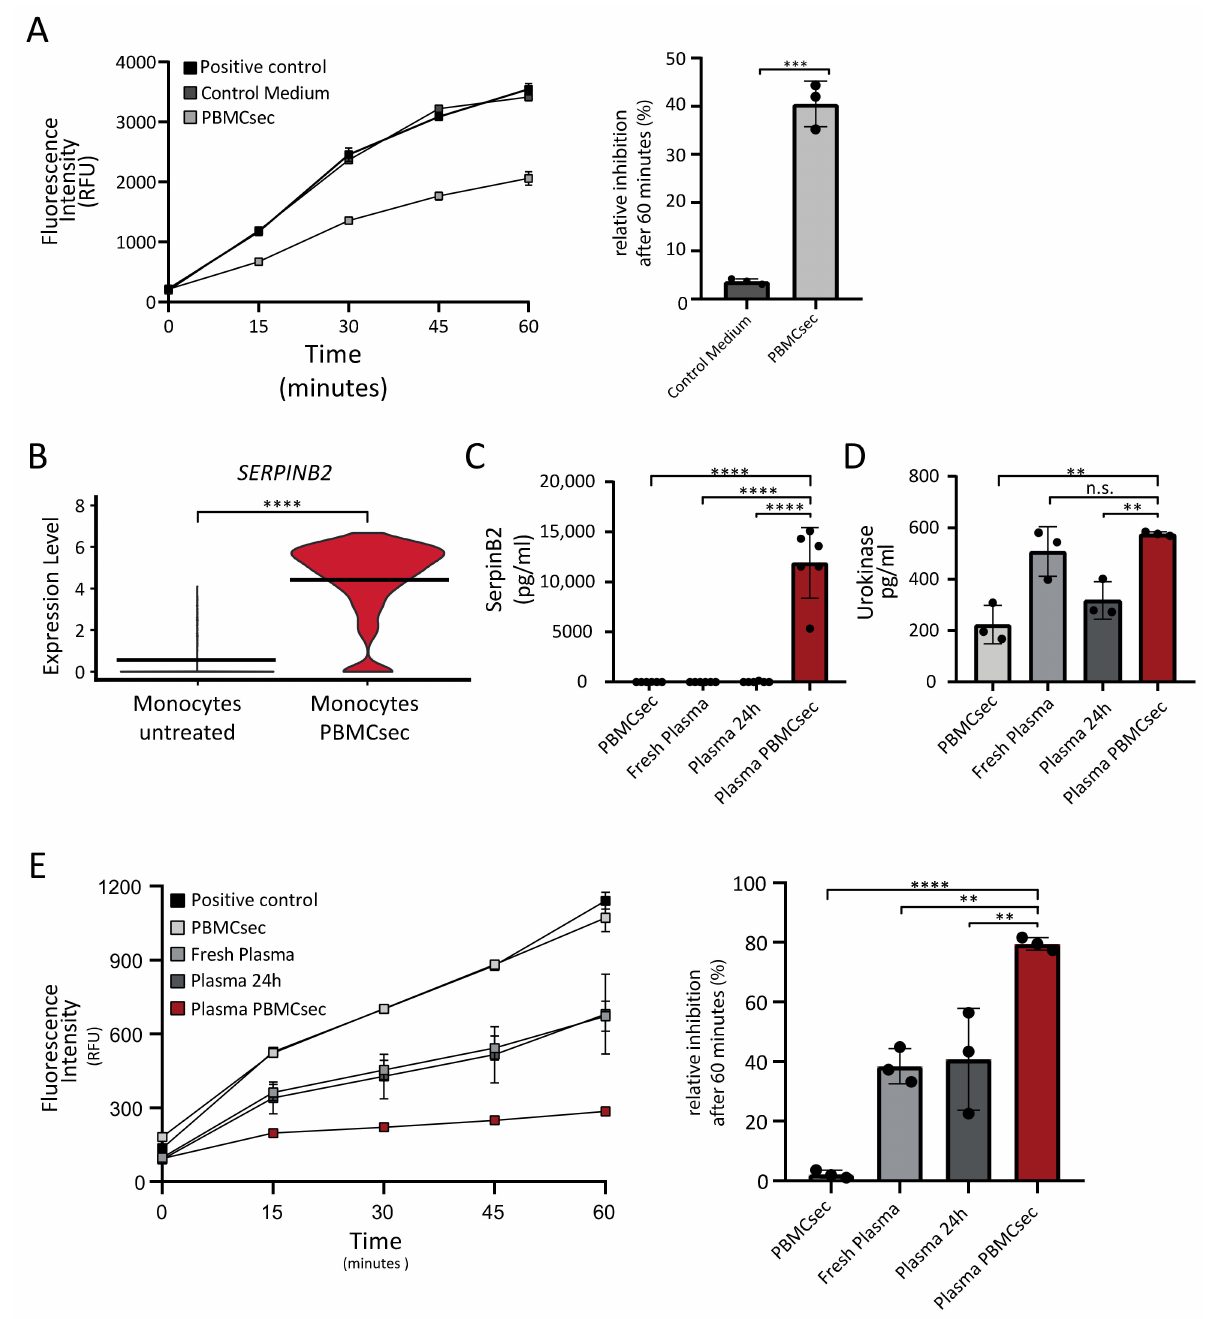
Figure 5. PBMCsec inhibits serine protease activity in vitro and increases levels of SERPINB2 in plasma of PBMCsec-treated whole blood. ( A ) Trypsin activity measured by increase in fluorescence intensity of cleaved substrate over time in the presence and absence of PBMCsec ( n = 3 biological replicates). ( B ) Gene expression of the urokinase inhibitor SERPINB2 in monocytes treated with PBMCsec ( p -value < 0.0001) compared to untreated monocytes. ( C ) SerpinB2 ( n = 3 biological replicates measured in duplicates) and ( D ) urokinase ( n = 3 biological replicates) protein levels of fresh plasma, untreated plasma, and plasma of PBMCsec-treated whole blood. ( E ) In vitro assessment of urokinase activity of fresh plasma, plasma from untreated whole blood, and plasma obtained from PBMCsec-treated whole blood. ** p < 0.01, *** p < 0.001, **** p <